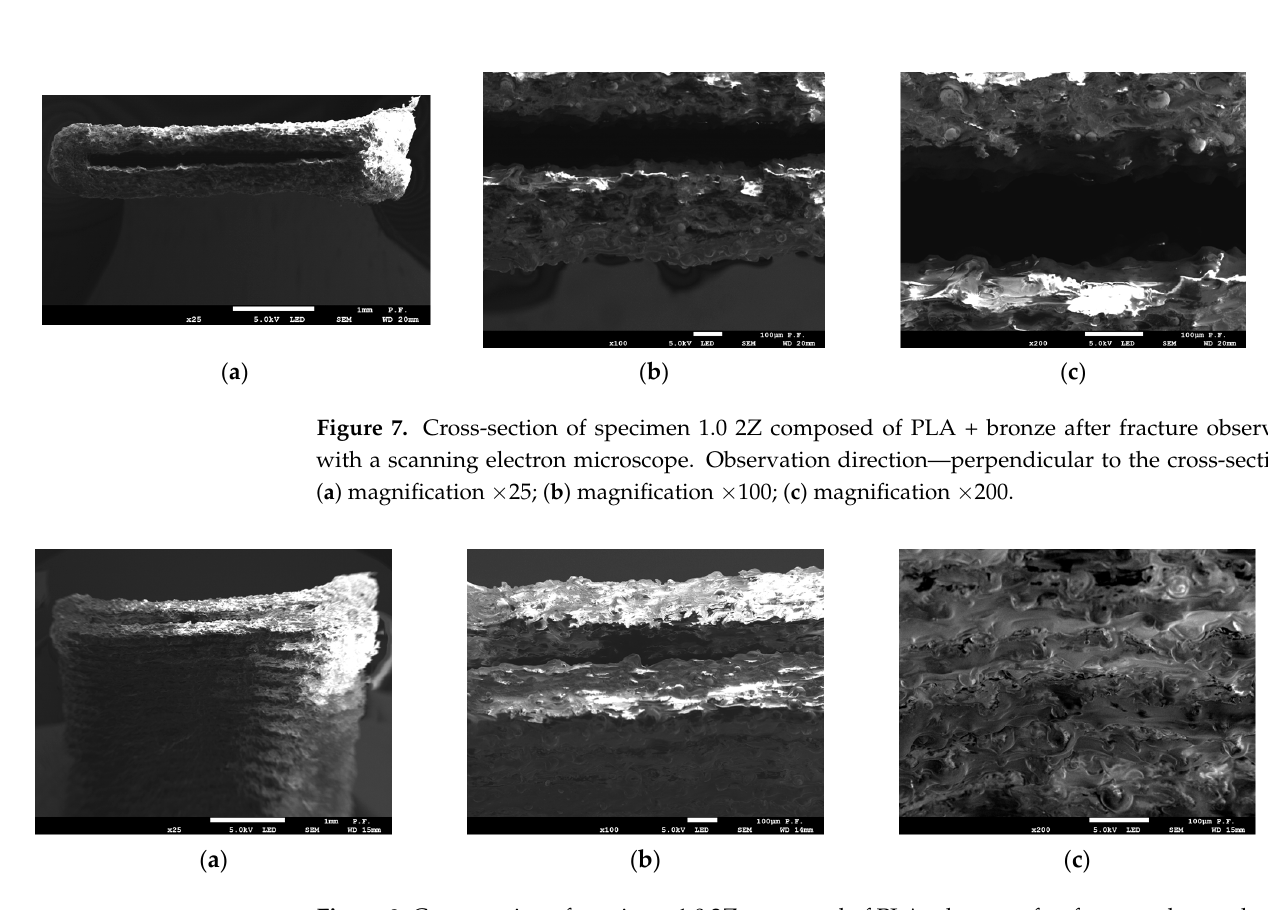
( d ) Figure 6. Cross-sections of the PLA + bronze specimens after fracture observed by means of a stere- oscopic microscope, magnification ×12; ( a ) specimen 4.0 2Z, with visible black areas indicating lack of filament (1); ( b ) specimen 4.0 5Y; ( c ) specimen 1.0 2Z; ( d ) specimen 1.8 5X. Figure 6a,b show the cross-sections of the 4 mm thick specimens printed in the Z and